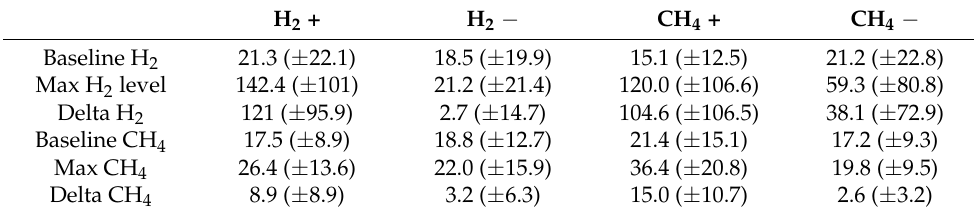
Table 2. Baseline and maximal values of H 2 and CH 4 in different